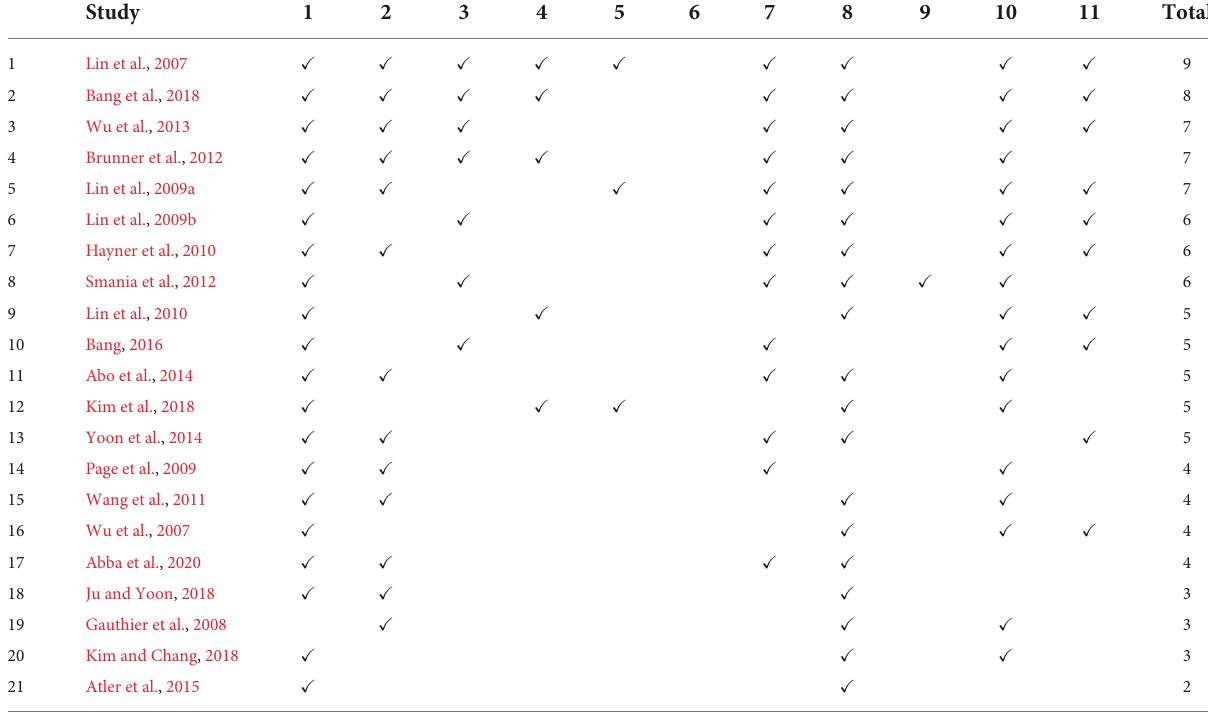
TABLE 1 Qualitative analysis of studies on the PEDro scale.